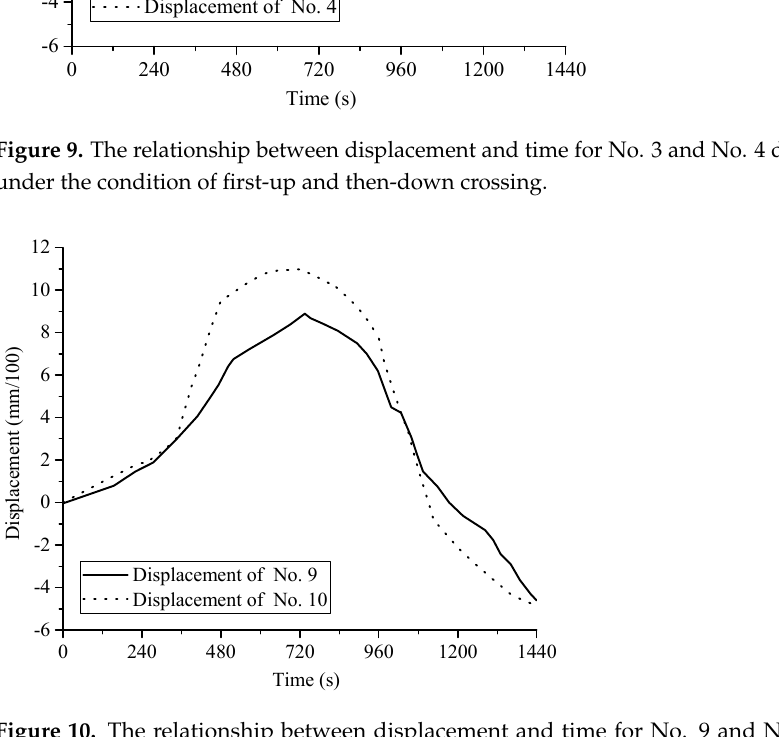
Figure 10. The relationship between displacement and time for No. 9 and No. 10 displacement meters, under the condition of first-up and then-down crossing.